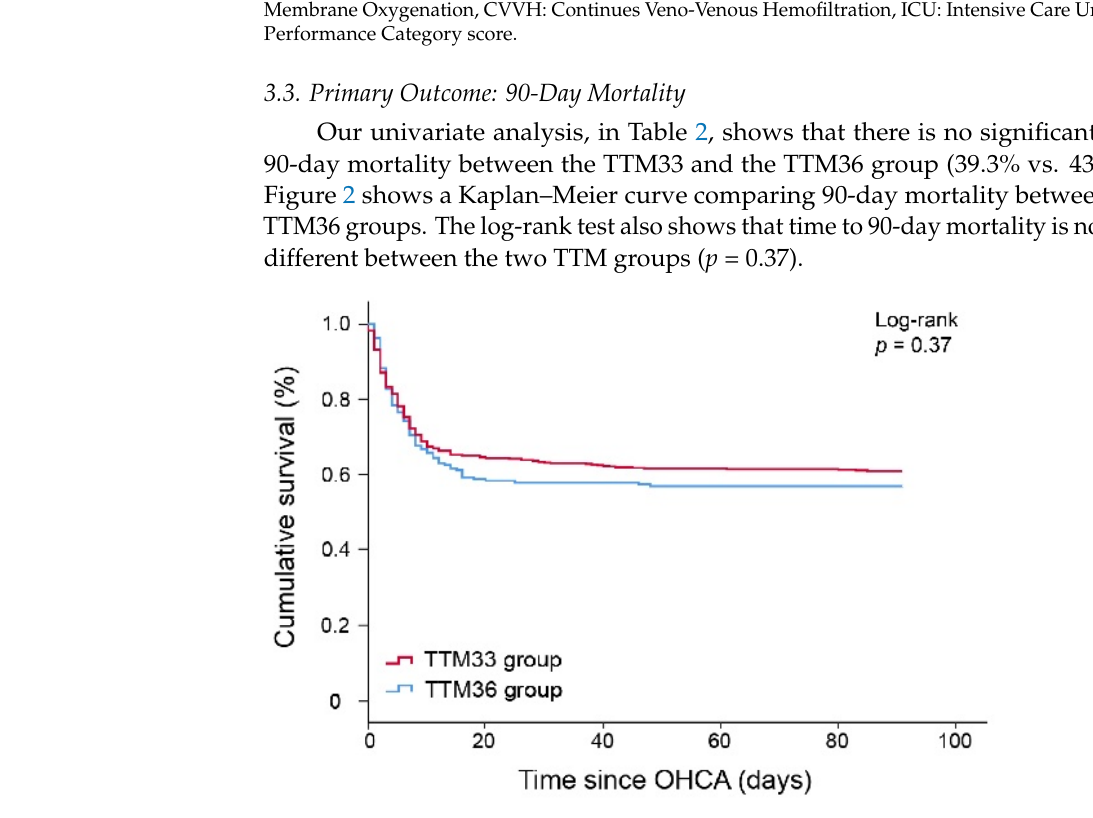
outcome at ICU discharge between both TTM groups ( p = 0.13; Table 2). Supplementary Table S3 shows a binary logistics regression model for favorable neurological outcome. The binary logistic regression reports no significant difference between the TTM33 and TTM36 group and favorable neurological outcome at ICU discharge (OR 1.330, 95% CI 0.941–1.879). Also, no significant difference was found between both TTM groups and